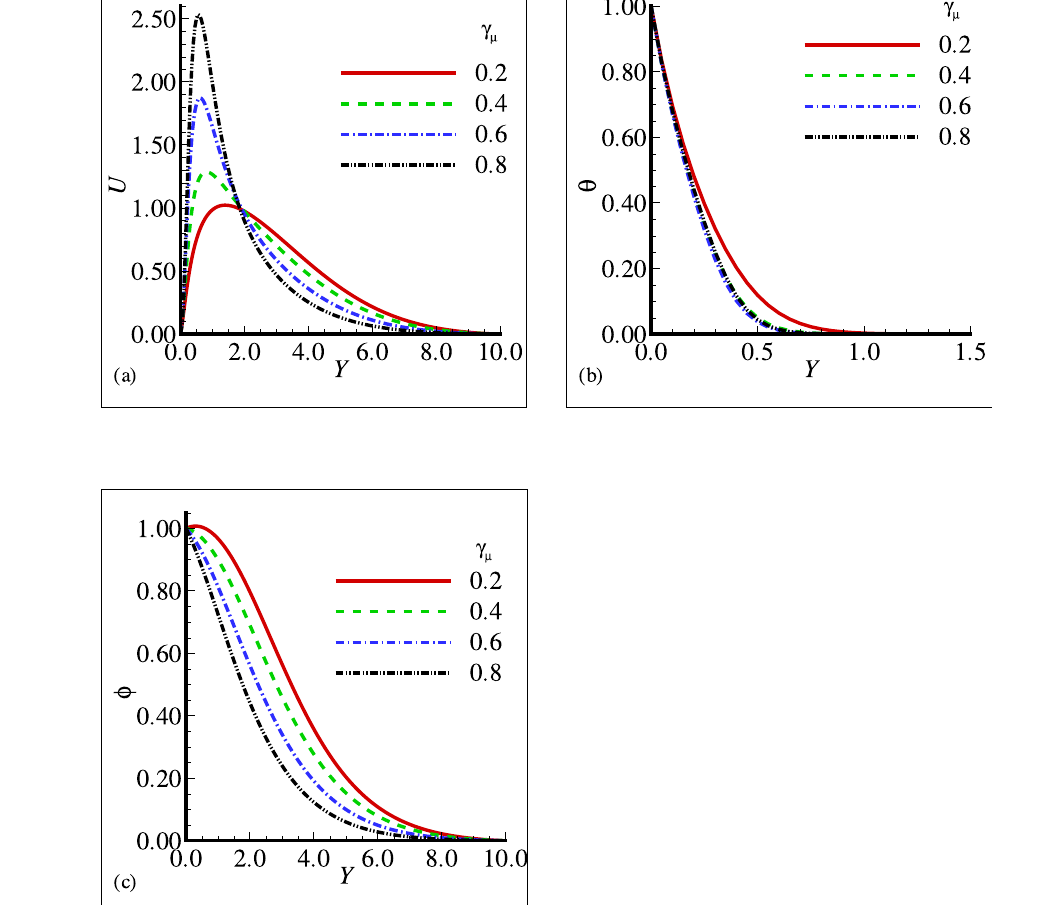
with n = 0.3, Pr = 7.0, Sc = 0.8, μ